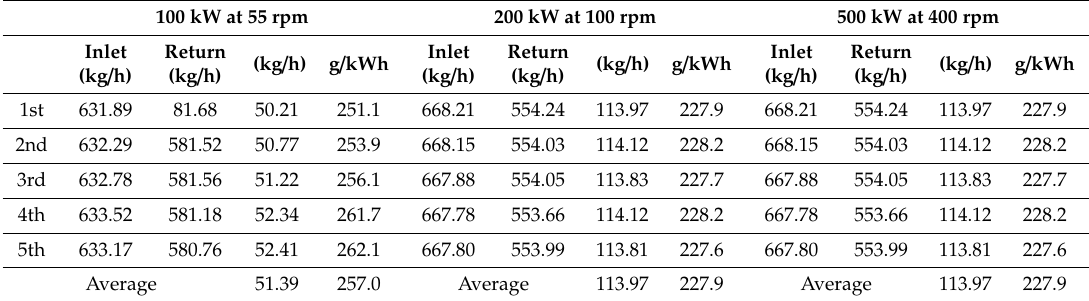
Table 5. Results of fuel consumption measurements.